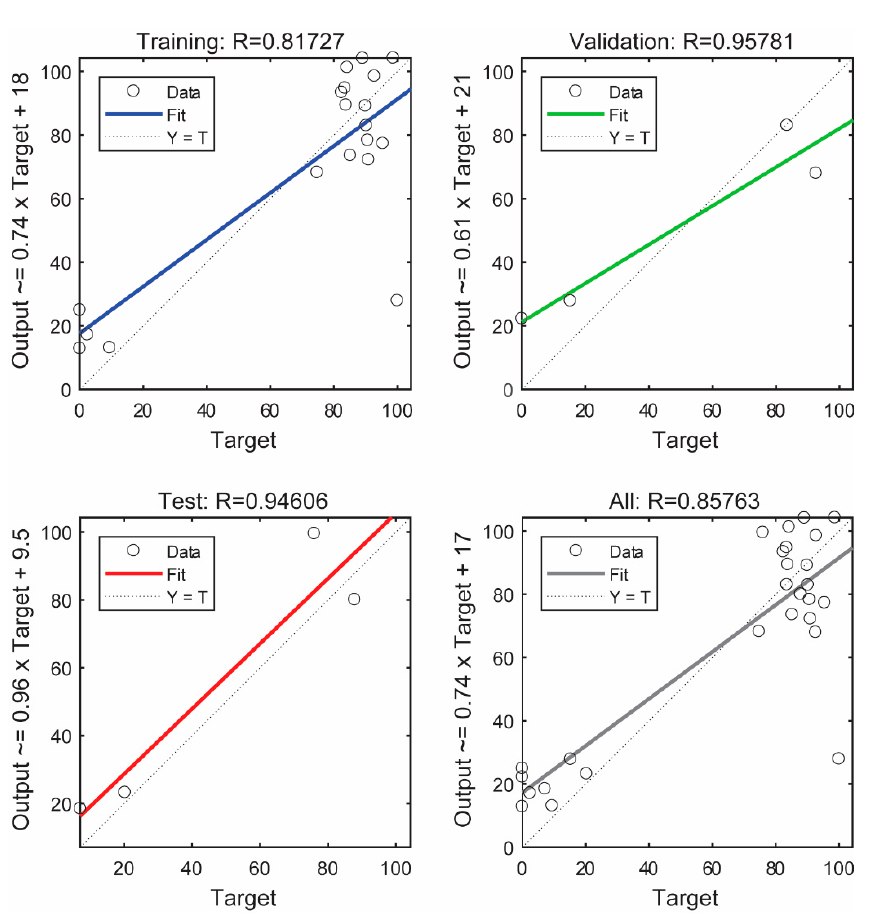
Figure 12. Training, validation, test, and overall regressed outcomes for predicting N 2 selectivity.